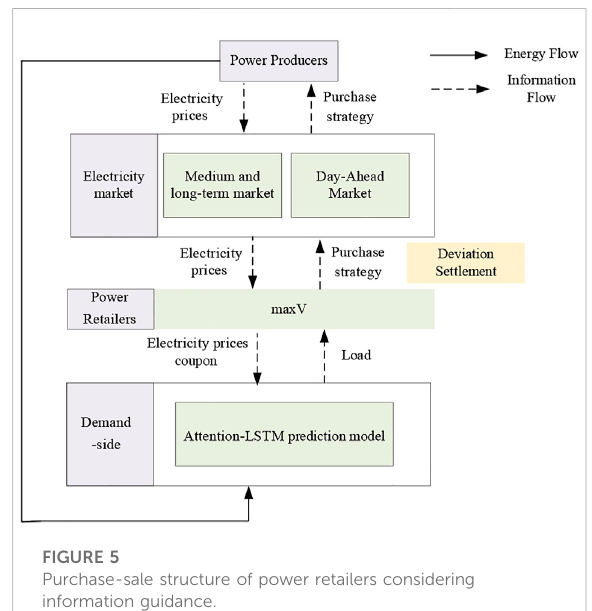
FIGURE 5 Purchase-sale structure of power retailers considering information